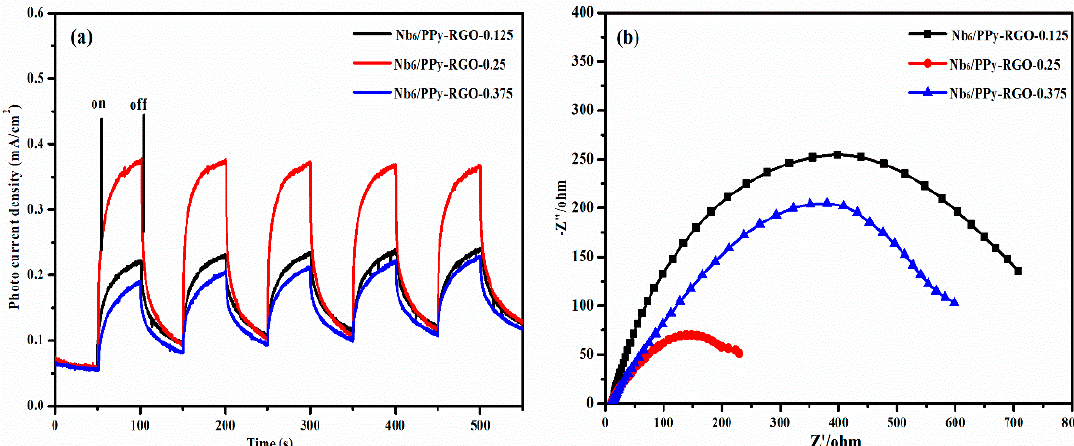
Figure 7. ( a ) Transient photocurrent response and ( b ) Electrochemical impedance spectroscopy (EIS) plots of Nb 6 /PPy-RGO-0.125, Nb 6 /PPy-RGO-0.25 and Nb 6 /PPy-RGO-0.375.